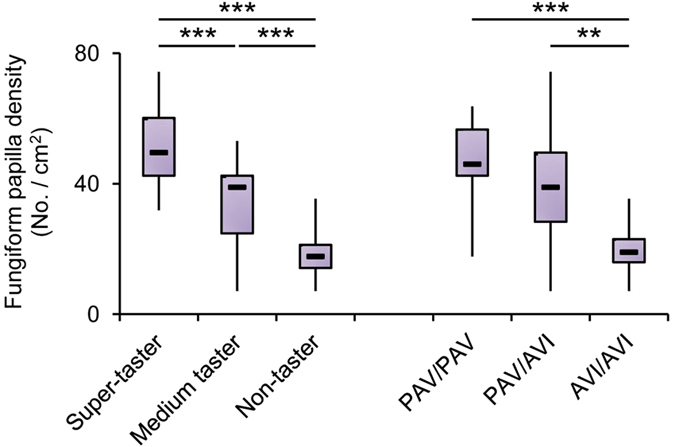
Relationship between the density of fungiform papillae and PROP taster status or TAS2R38 polymorphisms.One-way ANOVA: F2,40 = 29.447; P < 0.00001 or F2,40 = 8.842; P = 0.0007). The box-and-whisker plots show the minimum, first quartile, median, third quartile, and maximum of each set of data. n = 15 super-tasters, n = 15 medium tasters and n = 13 non-tasters; n = 7 individuals with genotypes PAV/PAV in TAS2R38 locus, n = 25 PAV/AVI genotypes and n = 11 AVI/AVI genotypes. **P < 0.01, ***P < 0.001 determined by the Newman-Keuls post hoc test.